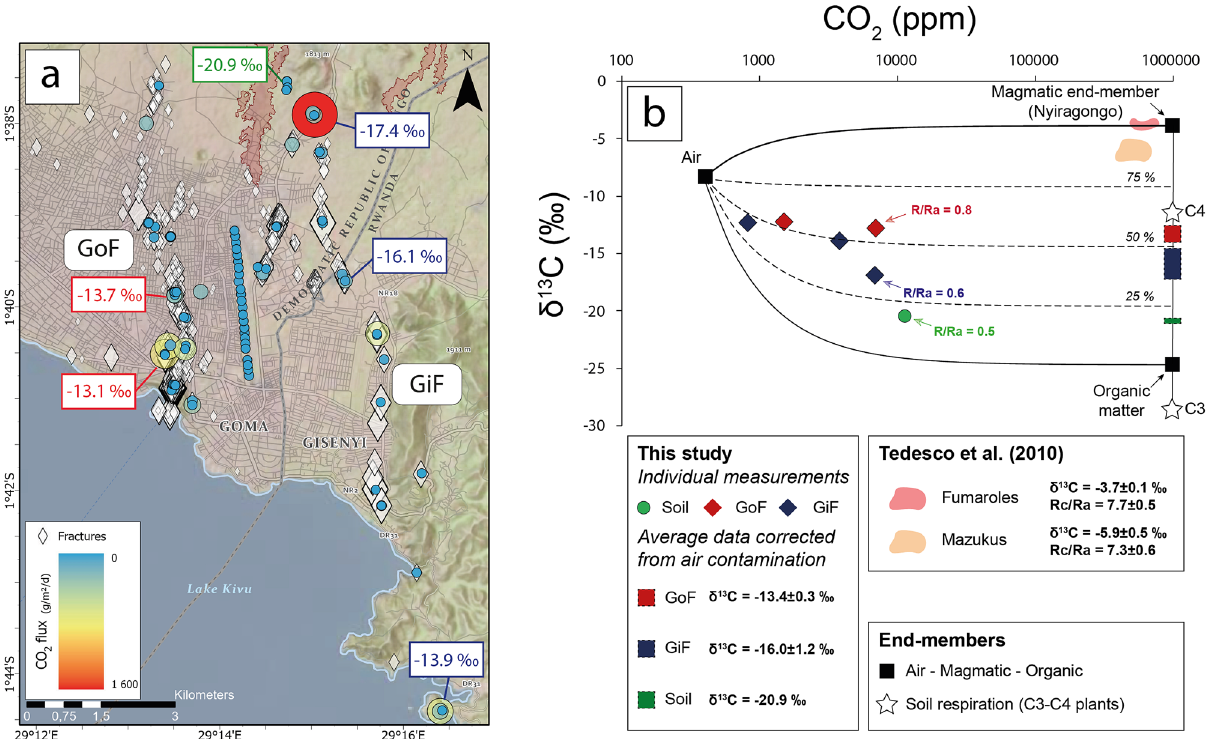
Figure 4. ( a ) Map of CO 2 flux with carbon isotopes values. ( b ) CO 2 content versus δ 13 C of CO 2 from fractures. The end-members used in the mixing model are defined in the “Methods”. Credits Attribution: Esri, NASA, NGA, USGS; RMLUA, OpenStreetMap, HERE, Garmin,